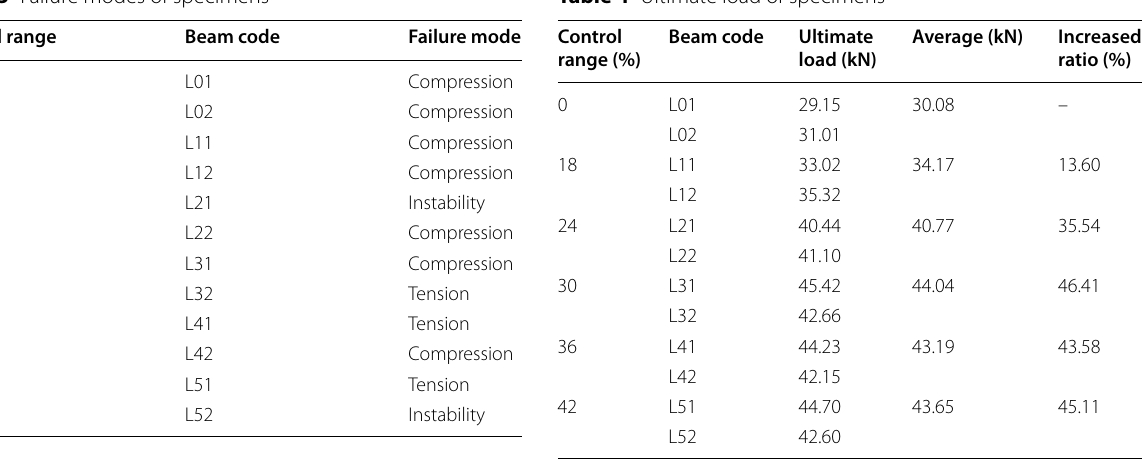
Table 4 Ultimate load of